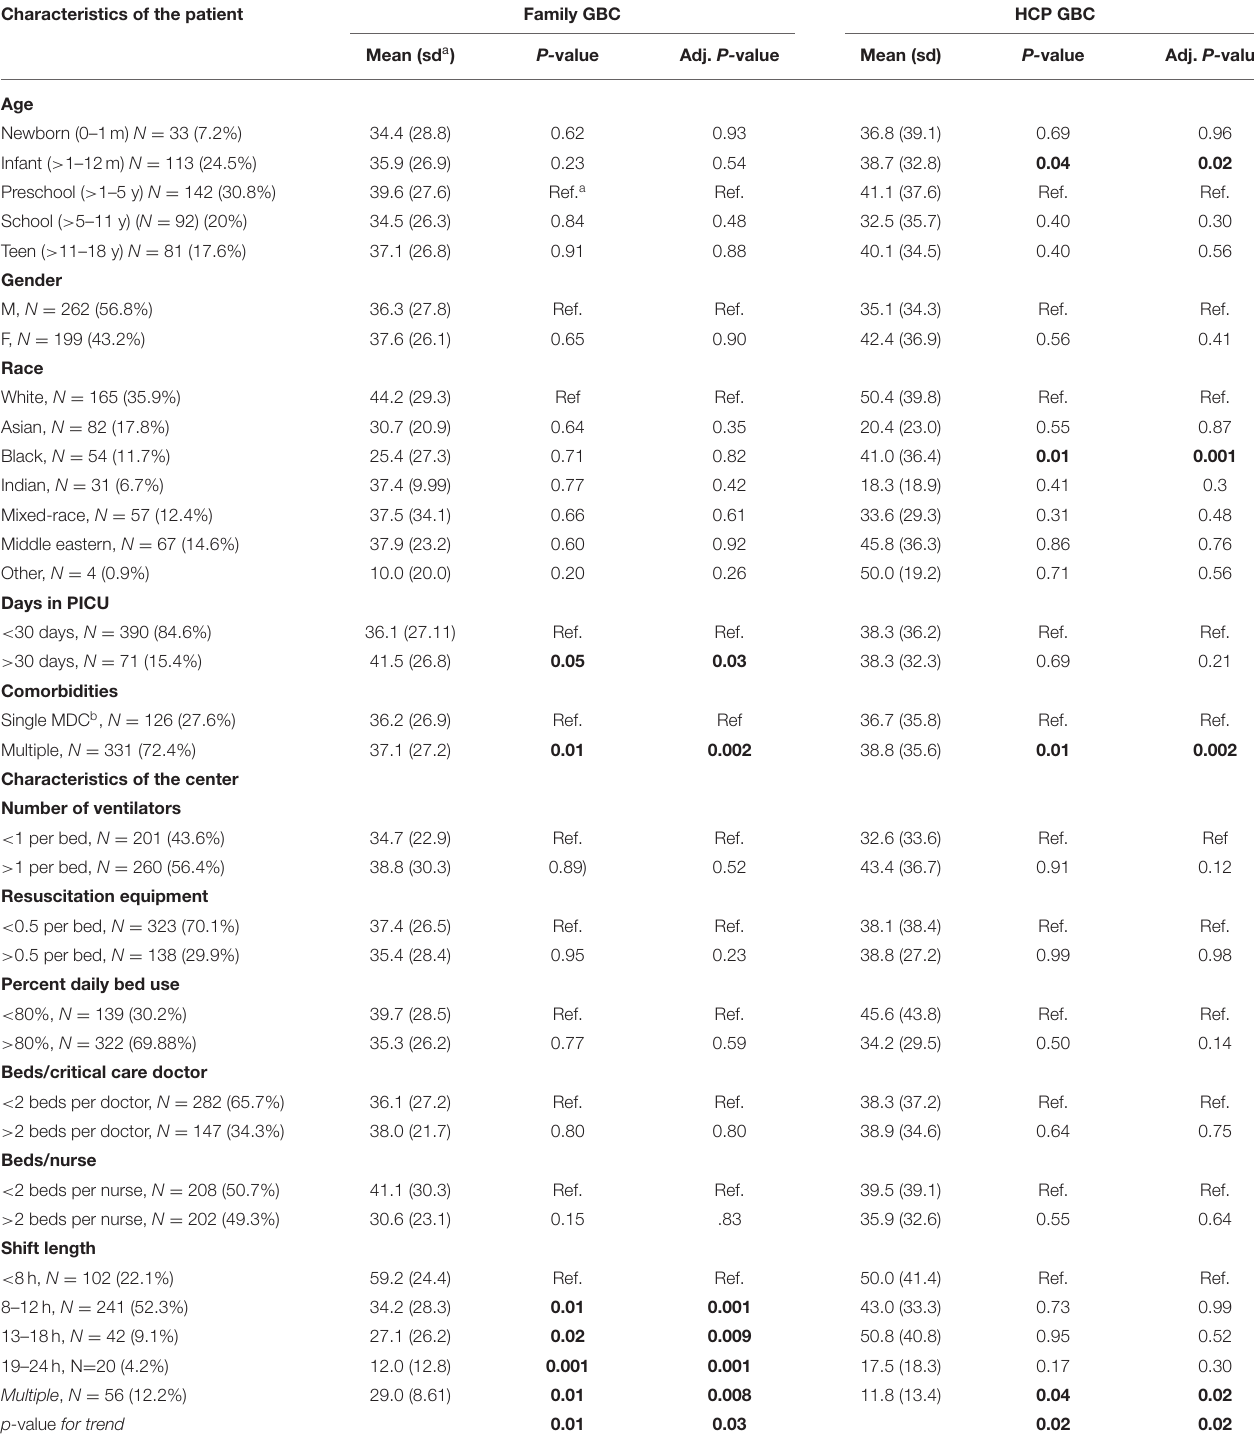
TABLE 2 | Associations between patient and center characteristic, and overall scores for domains 6A and 6B of the Initiative for Pediatric Palliative Care’s recommendations. Characteristics of the